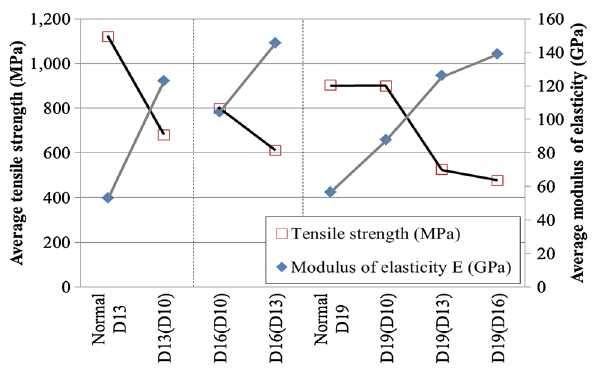
Fig. 8 Relationship between tensile strength and modulus of elasticity.